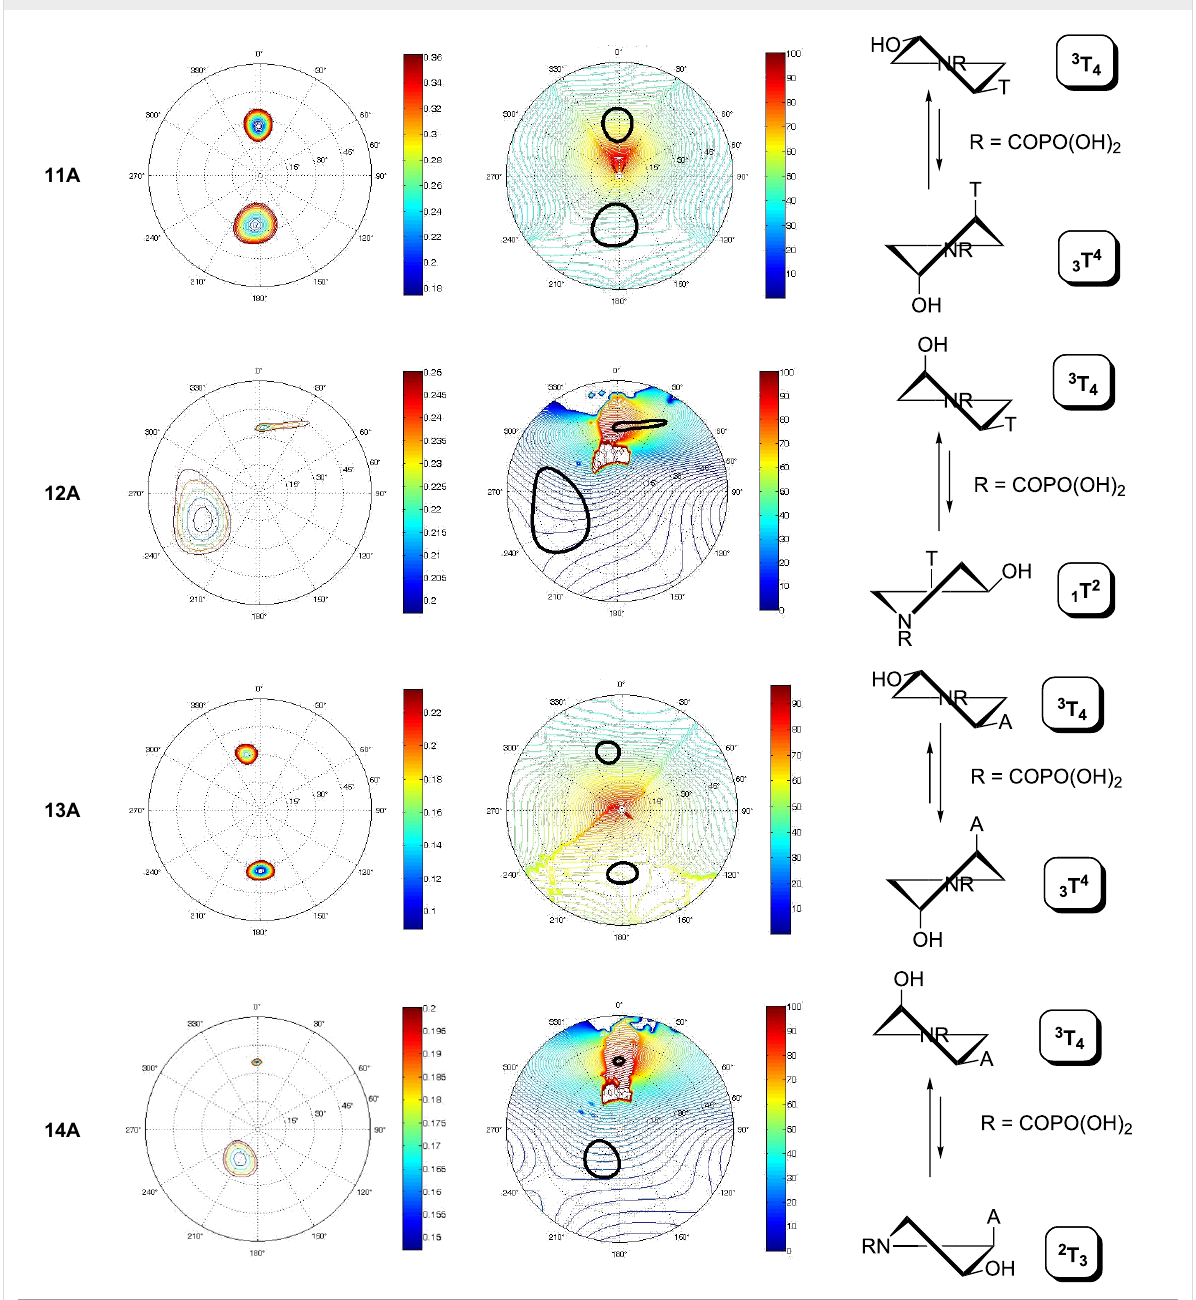
Table 3: The results of the conformational analysis.